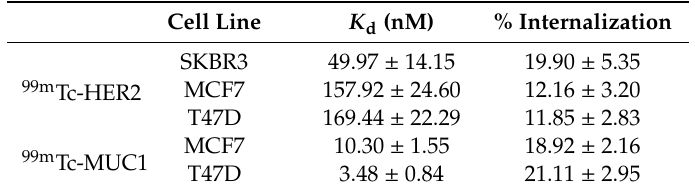
to respective receptor-positive breast cancer cell